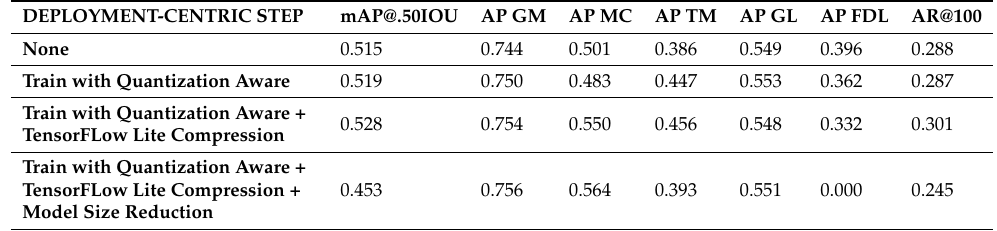
Table 6. Deployment-centric results for SSD